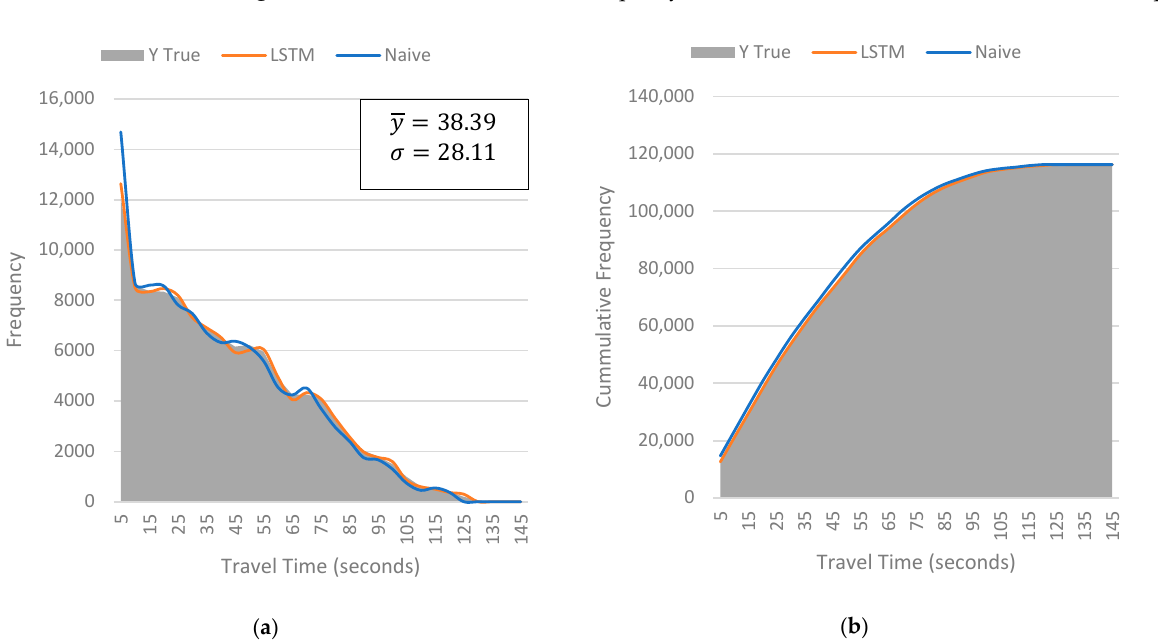
Figure 11. initial_values dataset. ( a ) Frequency, mean and standard deviation. ( b ) Cumulative frequency.